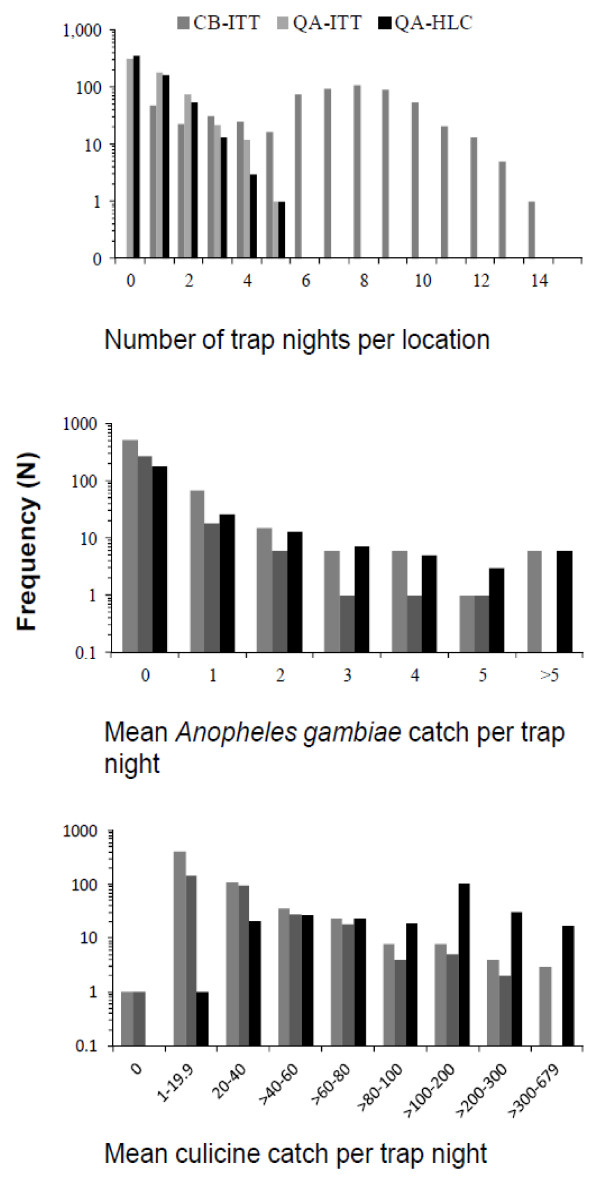
The frequency distributions of the person trap nights and mosquito densities across a range of survey locations by the three surveillance systems.